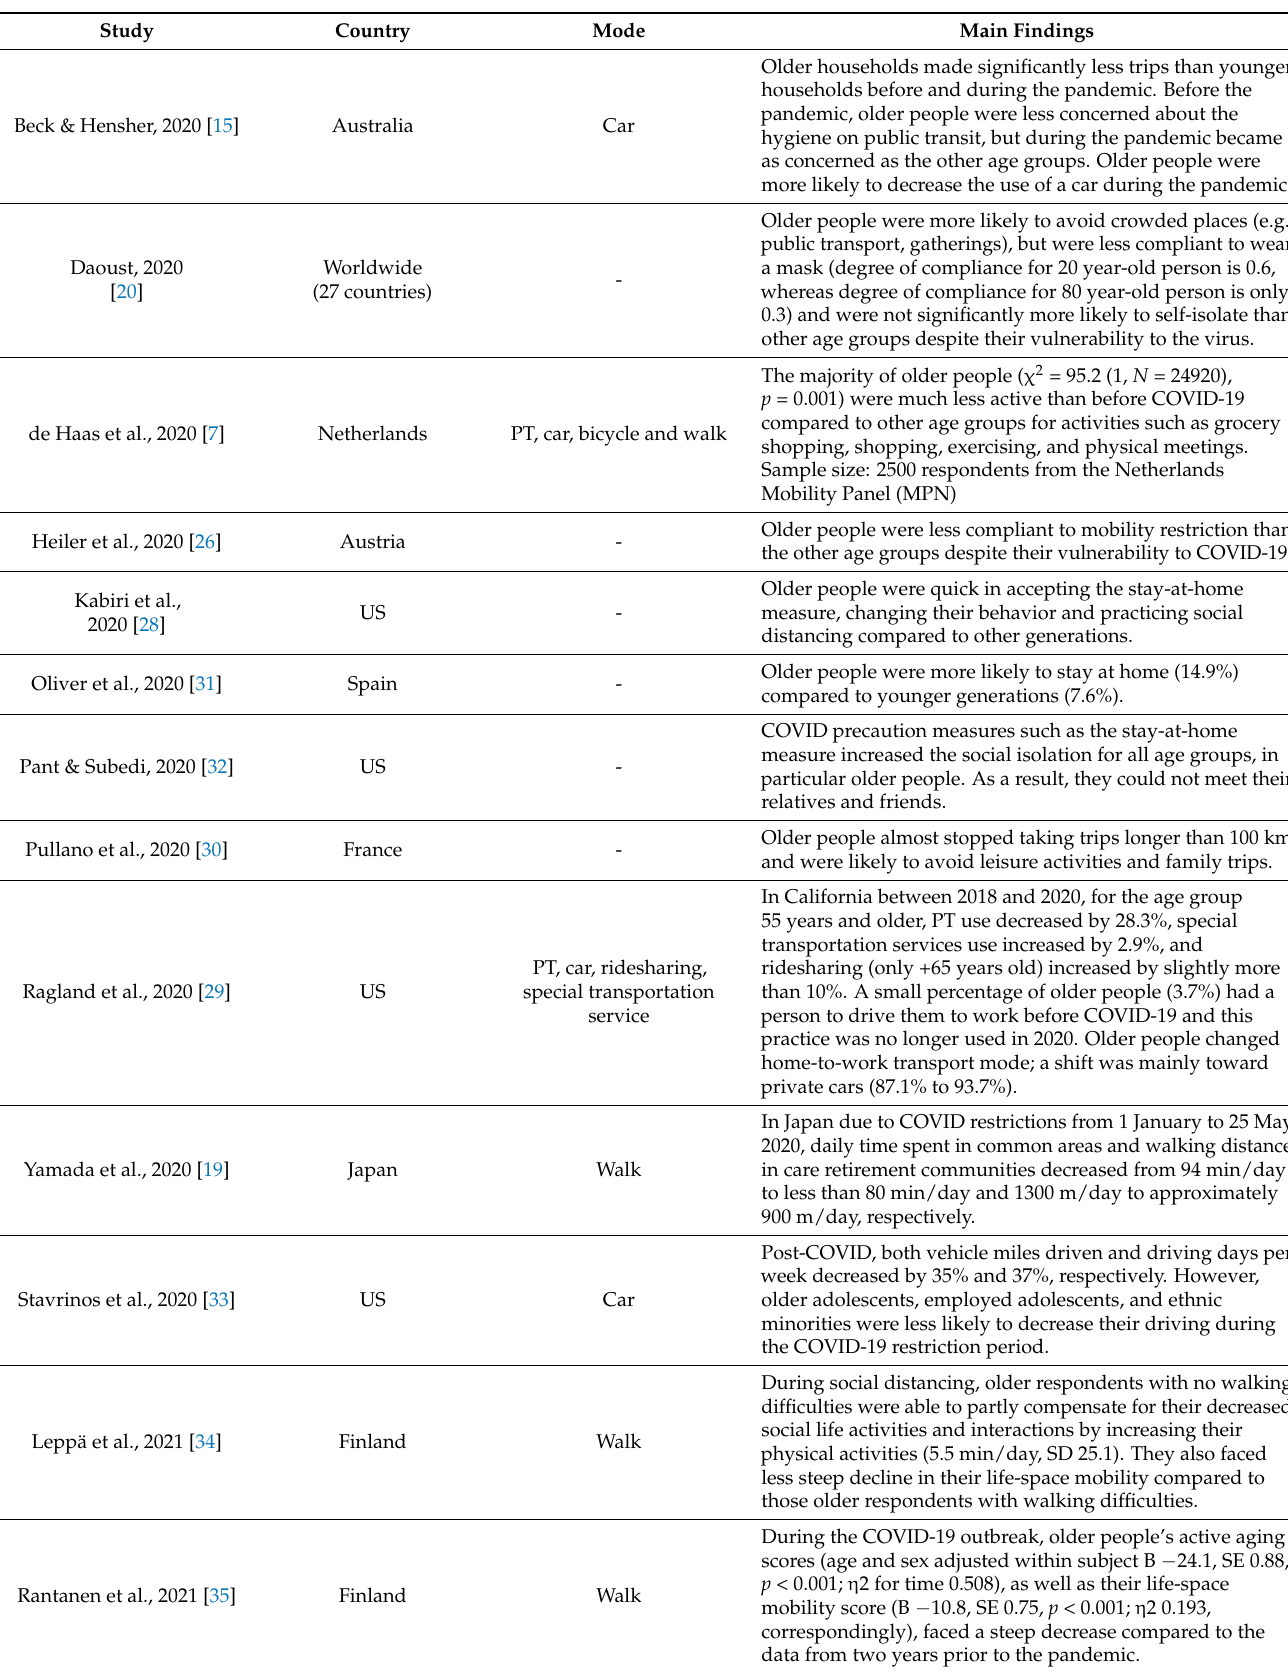
Table 1. Reviewed studies related to COVID-19 impacts on the mobility and activities of older